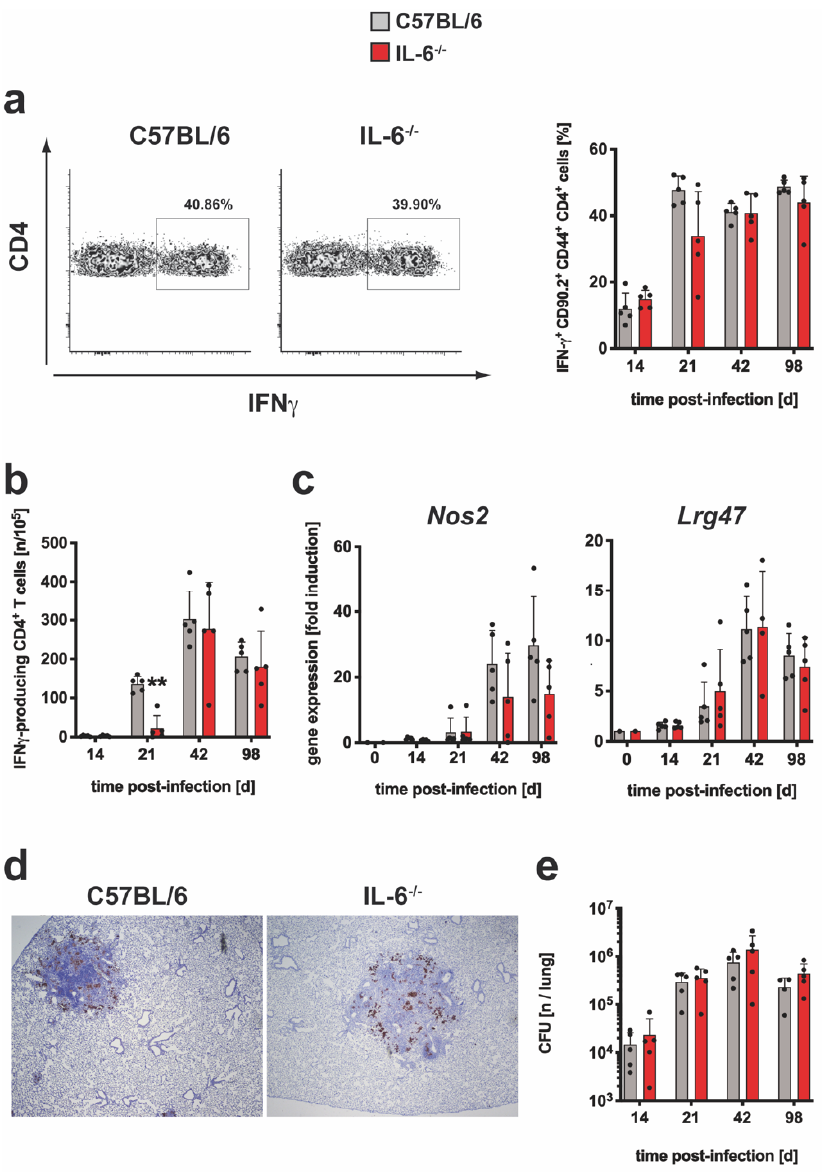
Figure 3. The TH1 immune response and macrophage effector functions in IL-6 − / − mice during experimental TB. C57BL/6 (grey symbols) and IL-6 − / − (red symbols) mice were infected with approximately 100 CFU Mtb via the aerosol route. At the indicated time points, lungs were removed and further processed. ( a ) The relative amount of IFN γ -producing CD4 + CD44 + CD90.2 + T cells was determined in single cell suspensions of lungs by flow cytometry after restimulation with anti-CD3/CD28. Representative density plot of IFN γ -producing CD4 + CD44 + CD90.2 + T cells on day 42 and IFN γ -producing CD4 + CD44 + CD90.2 + T cells during the course of infection are shown. ( b ) CD4 + T cells were purified from lung cell suspensions by MACS and restimulated with ESAT-6 1-20 . The frequency of IFN γ -producing cells was determined by ELISPOT. ( c ) Gene expression of Nos2 and Lrg47 was quantified by real-time RT-PCR based on gene expression in uninfected mice. ( d ) Representative immunohistochemical staining of NOS2 in lung sections of experimental mice 42 days of infection. ( e ) At the indicated time points, bacterial loads in the lungs were determined. Mean values with standard deviations of 5 mice per group are shown. One representative experiment of two is shown. Data were statistically analyzed using the Mann–Whitney test defining differences between C57BL/6 and IL-6 -/- mice as significant (**, p ≤ 0.01).